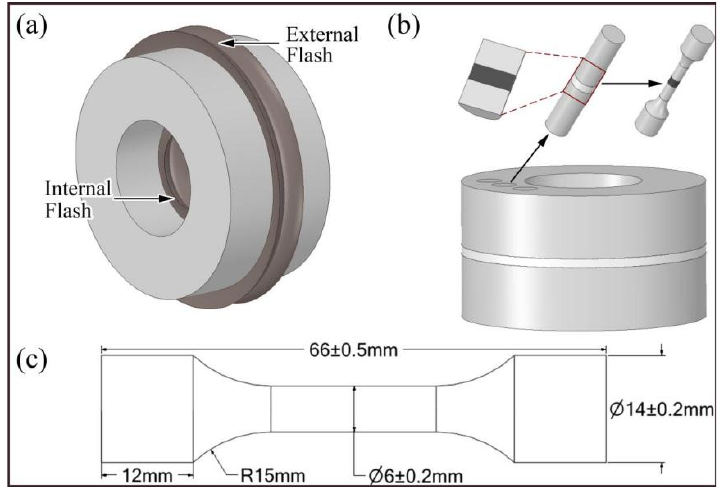
Figure 2. Schematic diagram of acquisition procedure of experimental samples: ( a ) short ring spec ‐ imen including IFW joint; ( b ) procedure of processing samples; ( c ) sample size. specimen including IFW joint; ( b ) procedure of processing samples; ( c ) sample